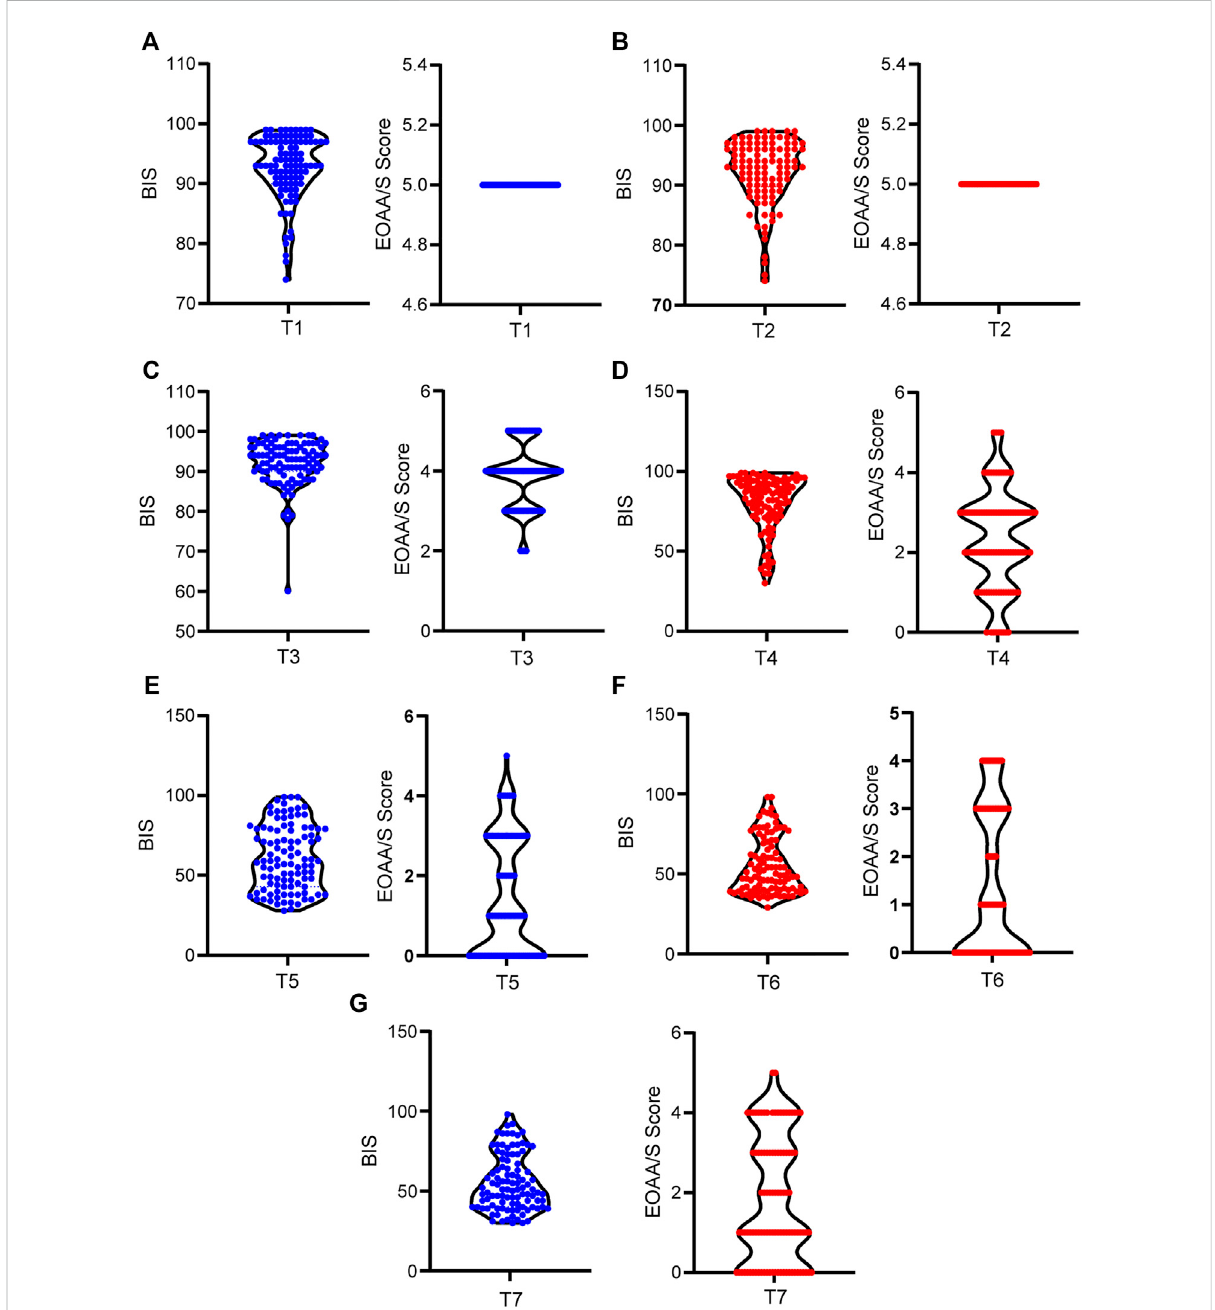
FIGURE 2 Individual differencesinBIS andEOAA/S scores duringetomidate anesthesia. (A) BIS andEOAA/S scoreswhenthepatients werequiet for5 min afterenteringtheoperatingroom; (B) BISandEOAA/Sscoresbeforeetomidateadministration; (C) , (D) , (E) , (F) ,and (G) BISvalueandEOAA/Sscoreat 30 s,60 s,90 s,120 sand150 s.T1,5 minafterthepatientsenteredtheroom;T2,beforetheadministrationofetomidate;T3,30 s;T4,60 s;T5,90 s; T6, 120 s; T7, 150 s after the